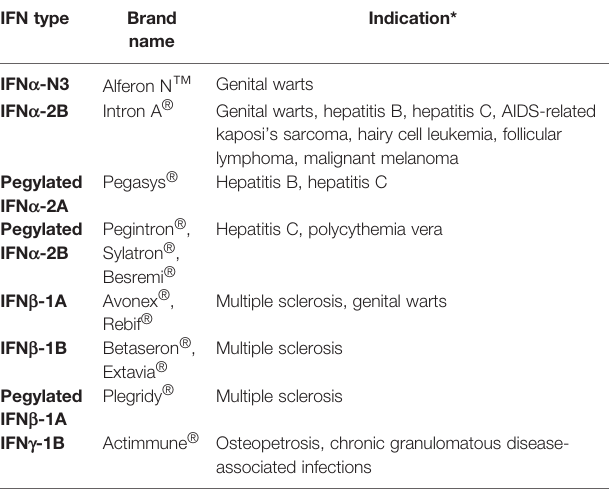
According to Drugs@FDA database (93). *According to Drugbank database